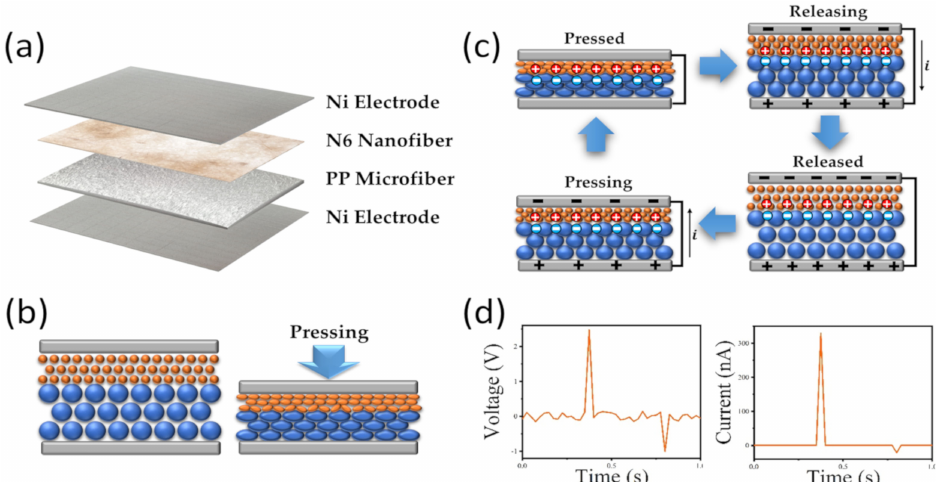
Figure 3. ( a ) Schematic of NMF-TENGs, ( b ) schematic of NMF-TENGs when external forces are applied and released, ( c ) schematic of the working mechanism of the triboelectric nanogenerators, and ( d ) electric output performances of NMF-TENGs generated by an external force during one cycle.